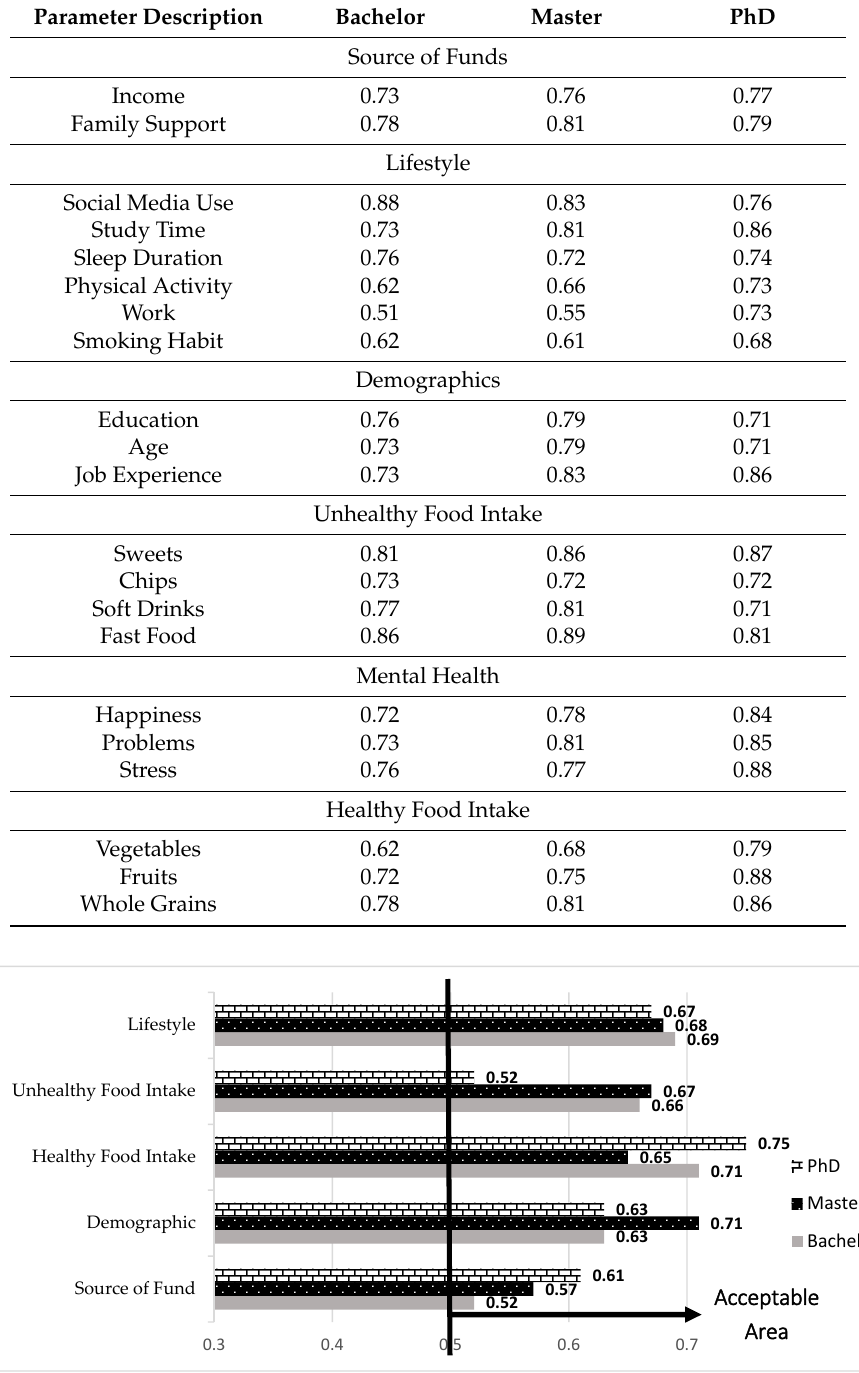
Table 4. Output of factor loadings related to latent research variables.